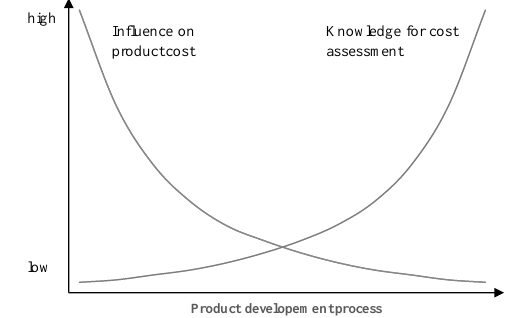
Figure 2: cost estimation along the product development pro- Fig. 2: cost estimation along the product development process [20] cess [20].